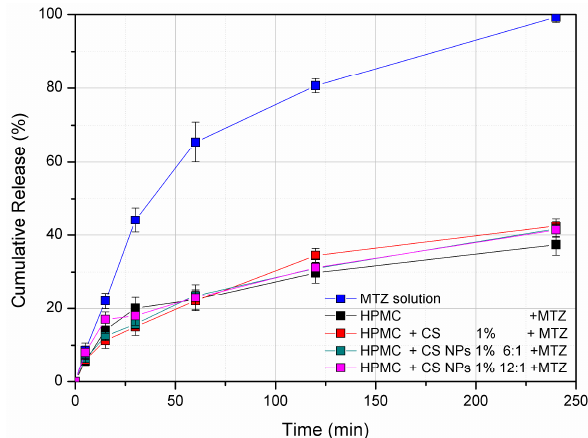
Figure 4. Metronidazole release from the prepared hydrogels (HPMC as control and HPMC/1% CS dispersion and HPMC/1% CS NPs) in 200 mM acetate buffer, pH 4.5, measured through Franz-diffusion cells apparatus. Values are reported as mean ± SD of three independent measurements.